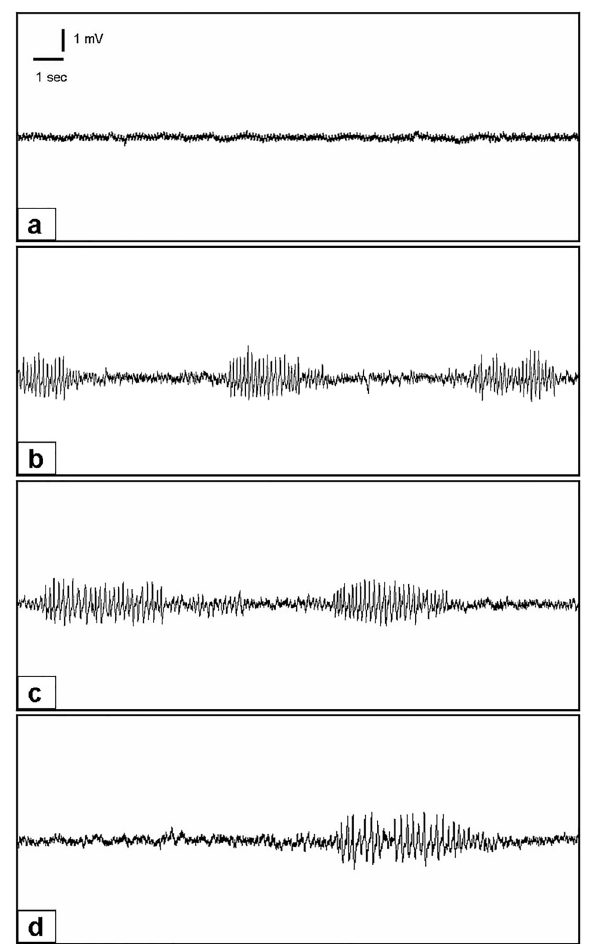
Figure 1. Representative EEG recordings from groups a : (A1, control), b : (A2, PTZ and saline), c : (A3, pentylenetetrazole (PTZ) and sulfasalazine (SSZ) at 250 mg/kg), and d : (A4, PTZ and SSZ at 500 mg/kg). As expected, there were virtually no spike waves seen in group A1. Dense spike wave activity was seen in group A2 due to the unopposed induction of seizures with 35 mg/kg of ip PTZ, with a mean spike wave percentage score of 74.6%. There was signi fi cant reduction (P o 0.05) of seizure activity as quanti fi ed by spike wave percentages in groups A3 and A4 with the addition of SSZ at 250 mg/kg (A3, 48.7%) and 500 mg/kg (A4, 33.8%) compared to A2. However, the marginal improvement seen between groups A3 and A4 were not statistically different from one